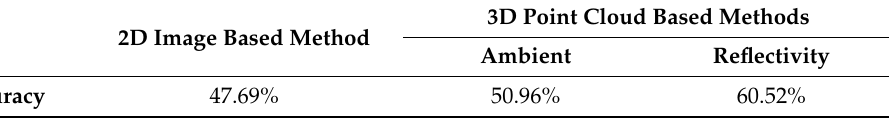
Table 2. Cyclist Joined Body and Head Orientation Estimation Accuracy of Different Usage of LiDAR